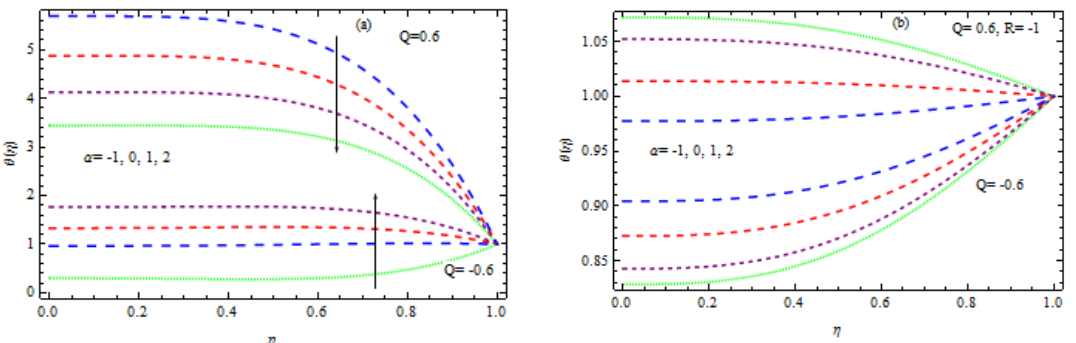
Figure 11. ( a , b ) Influence of wall 𝛼 on temperature.